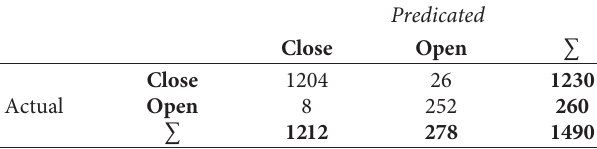
Table 2: Model prediction on